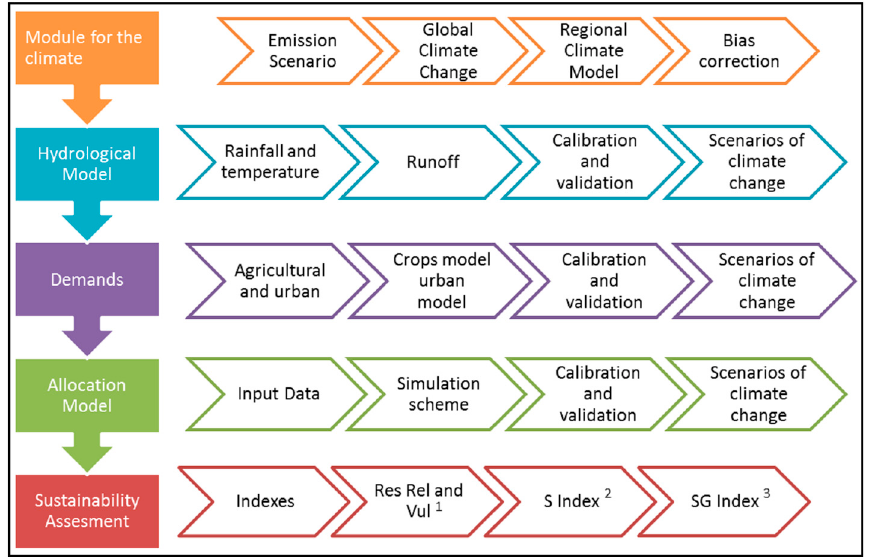
Figure 1. Scheme of the methodology applied. 1 Reliability, Resilience and Vulnerability; 2 Sustainability Index; 3 Sustainability by Groups.